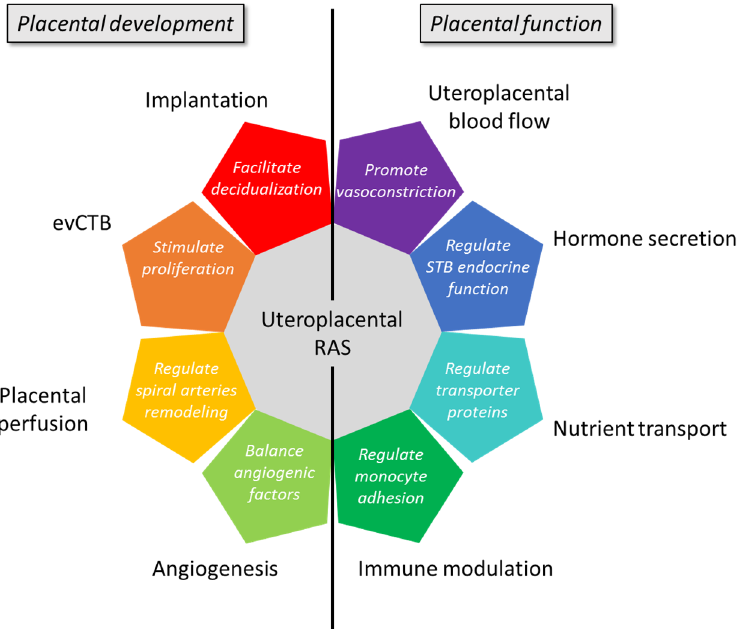
Figure 2. Role of the uteroplacental renin–angiotensin system (RAS) in placental development and function. evCTB: extravillous cytotrophoblasts; STB: syncytiotrophoblast.